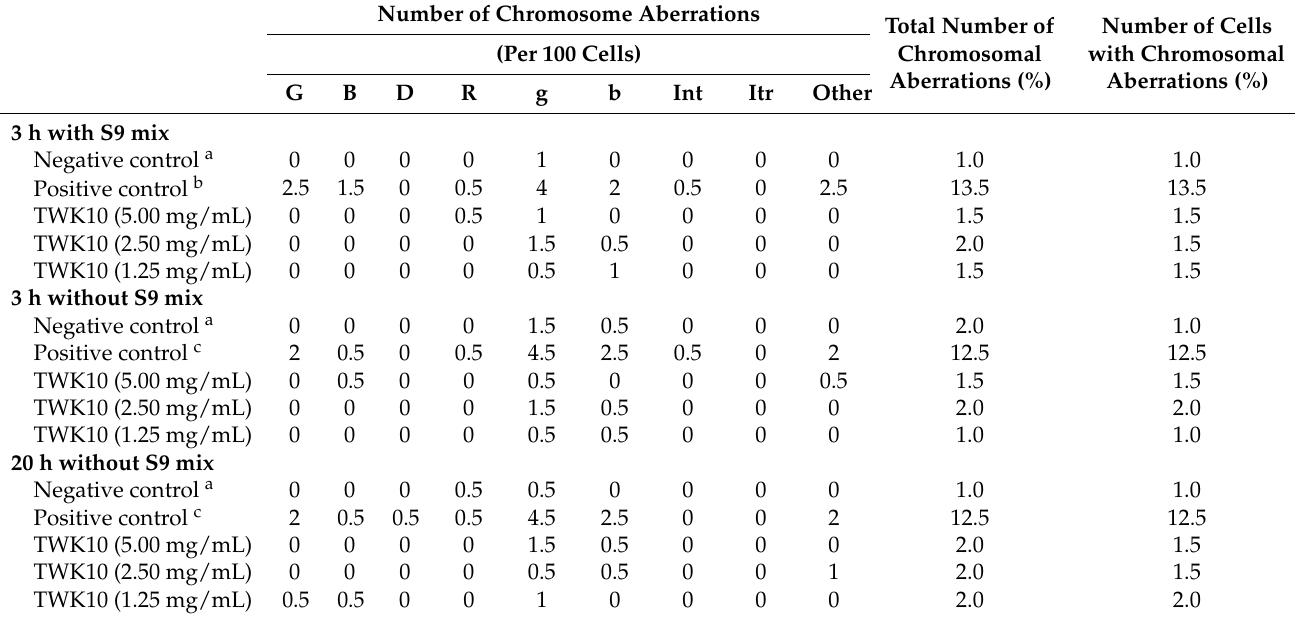
Table 4. Chromosomal aberration test for TWK10 in CHO-K1